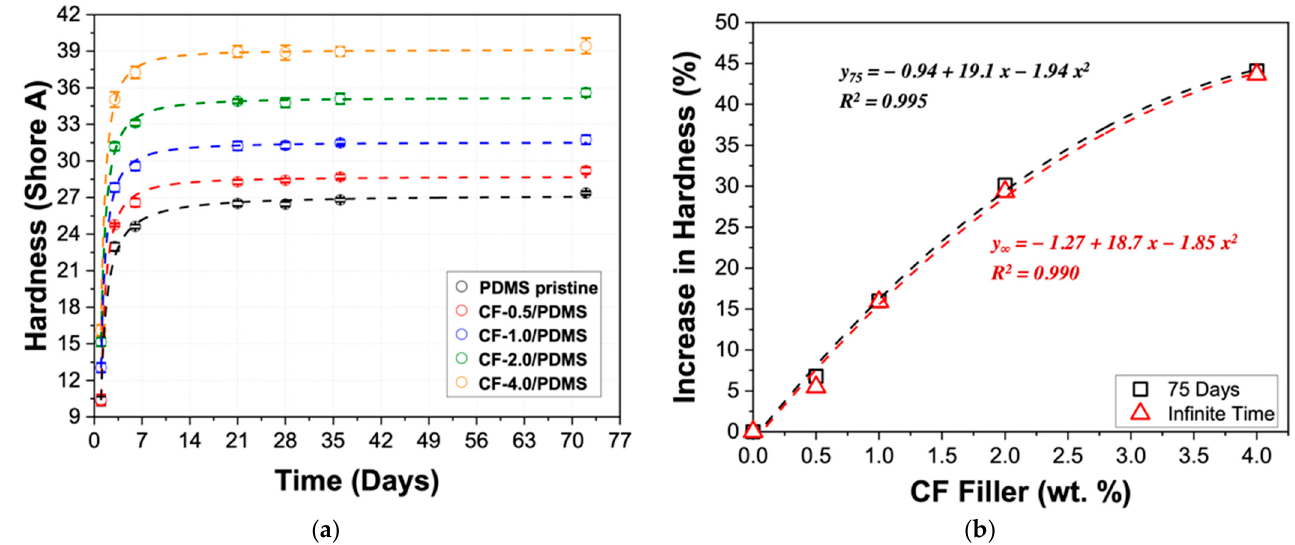
Figure 3. ( a ) Shore A hardness for CF-filled PDMS samples from 1 to 72 days; data fit using logistic curves. ( b ) Percent increase in hardness compared with PDMS pristine. The black data show an increase in hardness using 72-day hardness, and the red data show an increase in hardness at infinite time, determined using fits from the left graph.